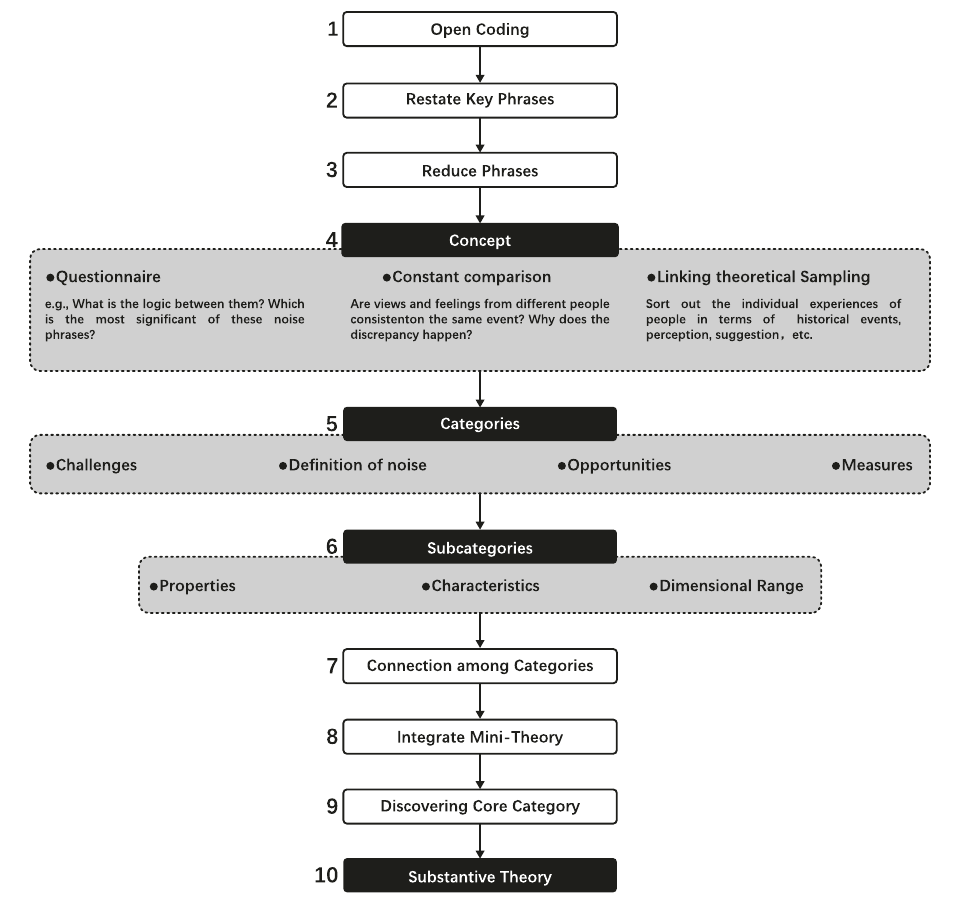
Fig. 4 The grounded theory-based